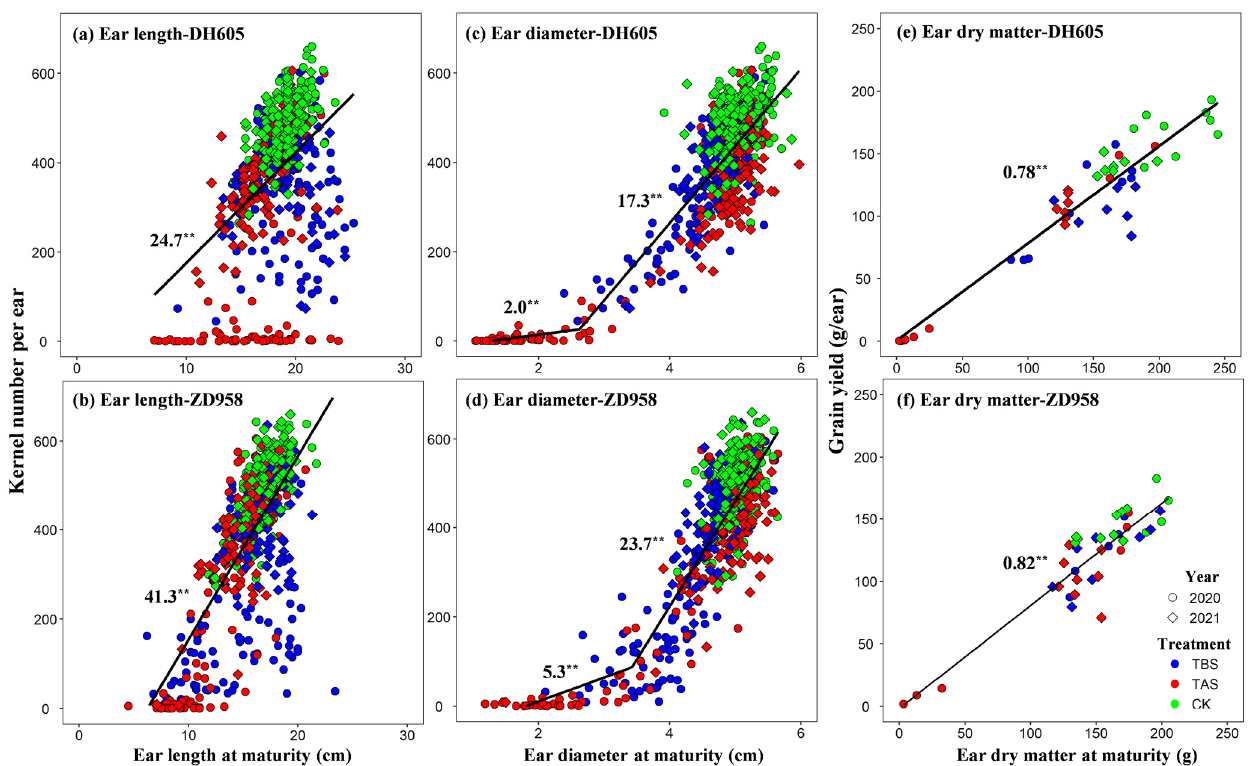
Figure 5. The relationship between ear length, ear diameter and kernel number per ear ( a – d ) and between ear dry matter and yield per ear ( e,f ). **, significantly different at p <